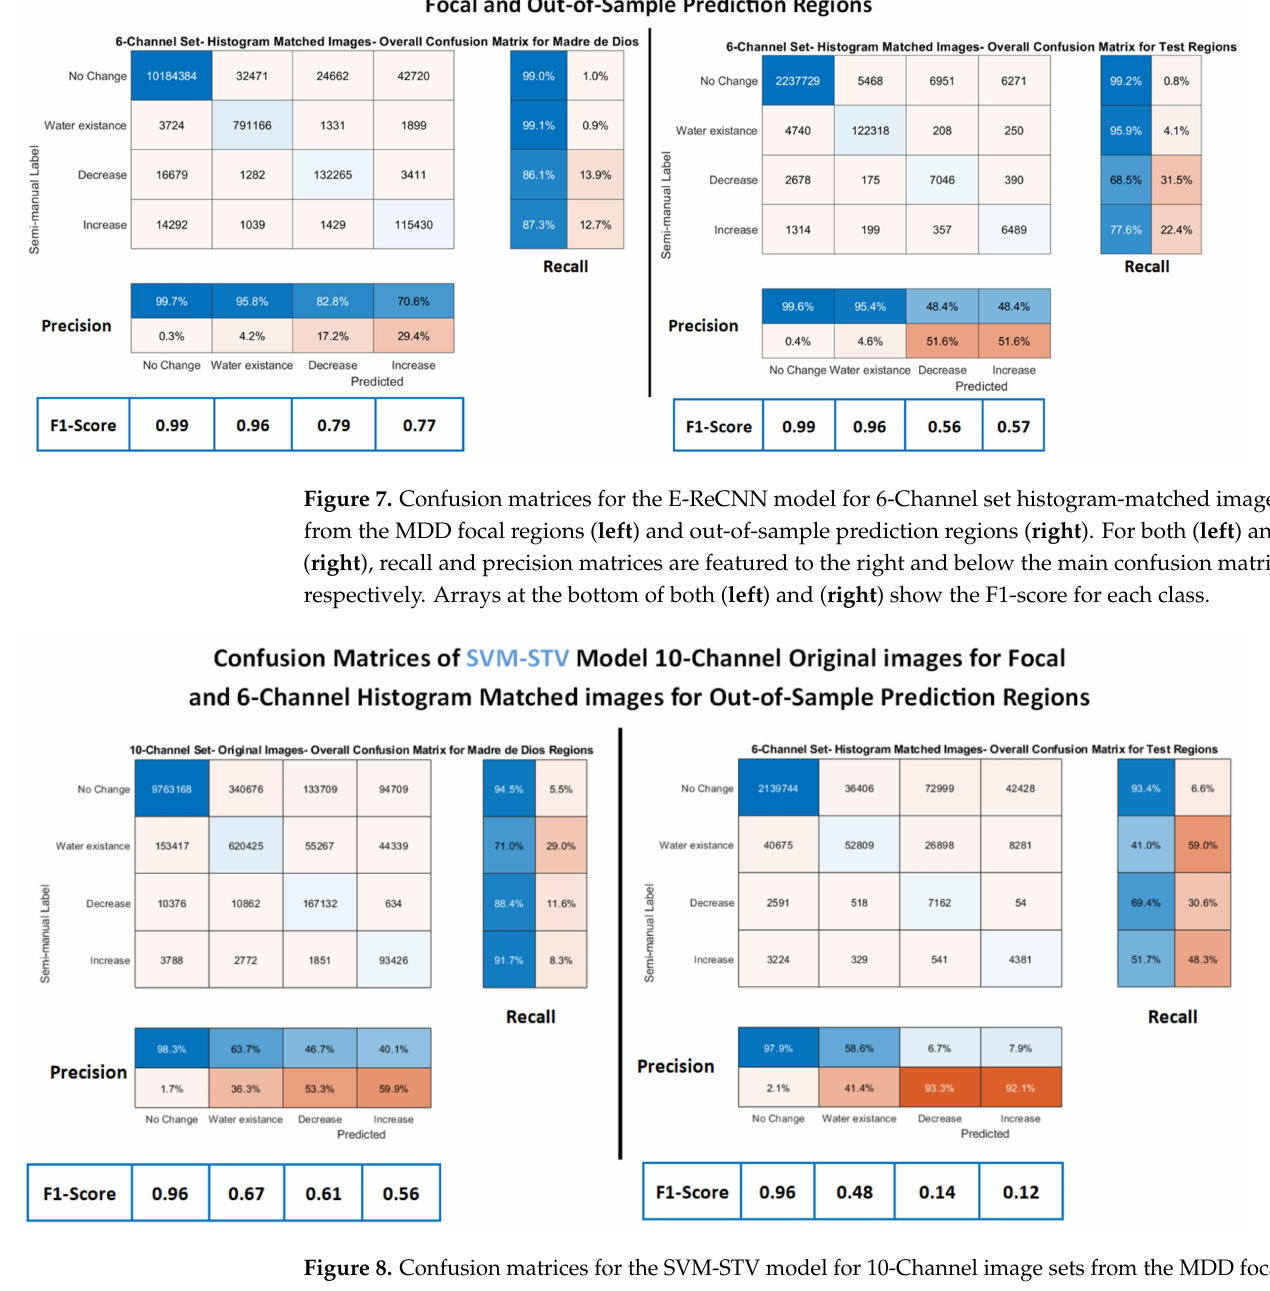
Figure 8. Confusion matrices for the SVM-STV model for 10-Channel image sets from the MDD focal regions ( left ) and 6-channel histogram-matched images for the out-of-sample regions ( right ). For both ( left ) and ( right ), recall and precision matrices are featured to the right and below the main confusion matrix, respectively. Arrays at the bottom of both ( left ) and ( right ) show the F1-score for each